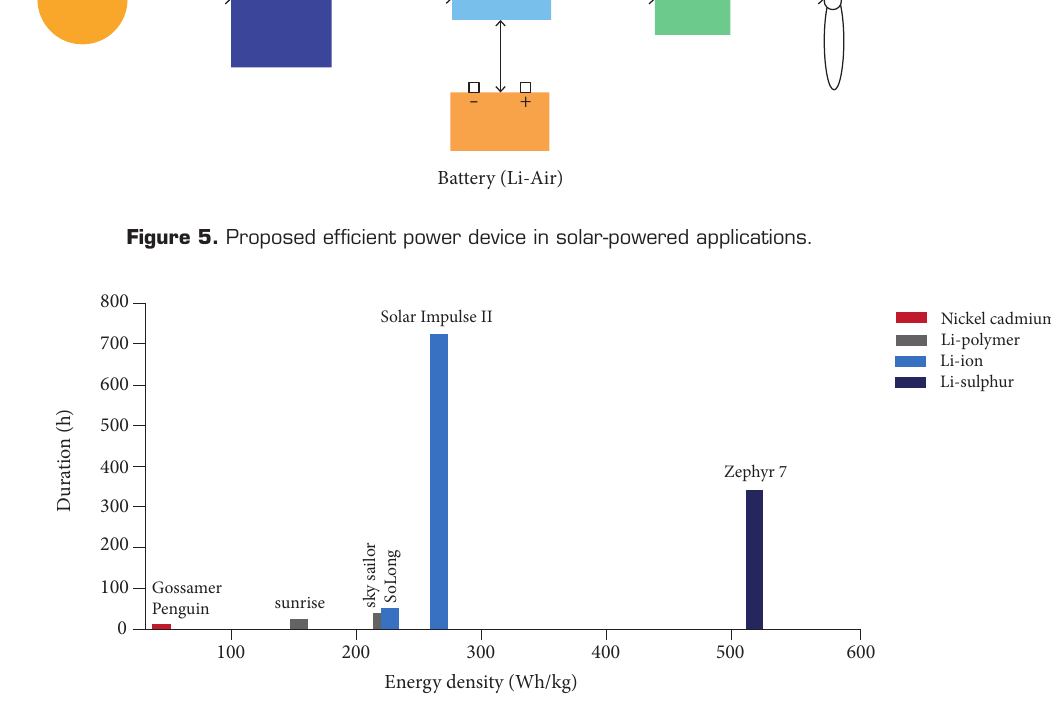
Figure 6. Solar-powered aircraft energy density and flight